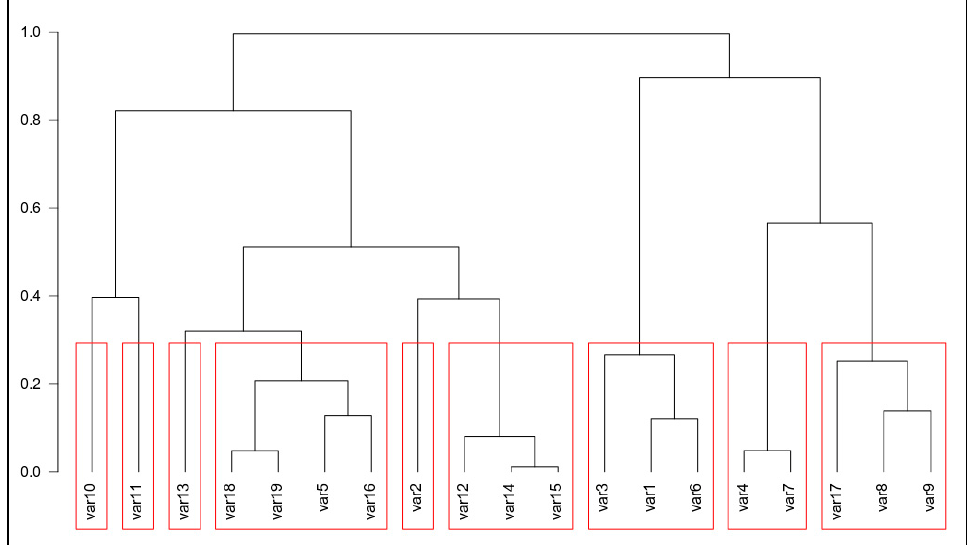
Figure 3. Groups of intercorrelated variables from the CliMond v.1.2 dataset at cutoff 0.7; y -axis as in Figure 1. Variables (var): var1—annual mean temperature, var2—mean diurnal temperature range, var4—temperature seasonality, var10—precipitation of driest week, var11—precipitation seasonality, var13—highest weekly radiation, var15 -radiation seasonality, var16—annual mean moisture index, var17—highest weekly moisture index. Discarded variables: var3—isothermality, var5—max. temperature of warmest week, var6—min. temperature of coldest week, var7—temperature annual range, var8—annual precipitation, var9—precipitation of wettest week, var12—annual mean radiation, var14—lowest weekly radiation, var18—lowest weekly moisture index, var19—moisture index